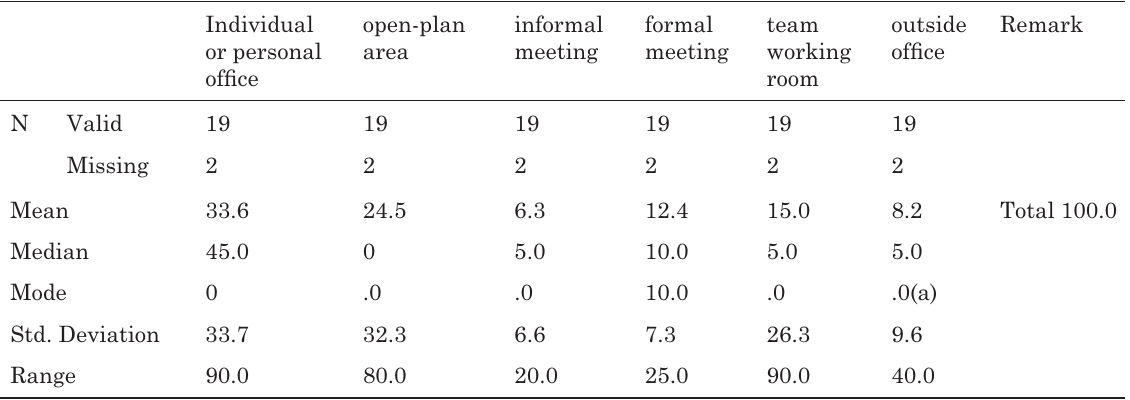
Flexible Working in Scottish Local Authority Property Table 2. Working hours in different working area